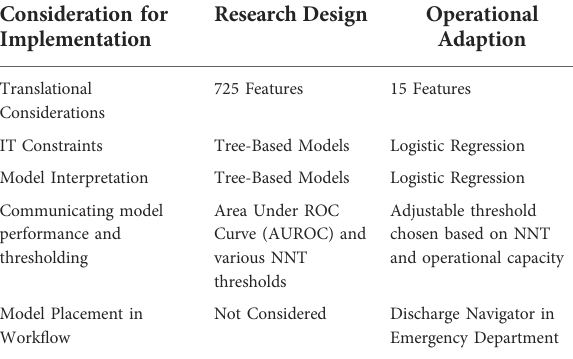
TABLE 1 Guiding considerations: from research to